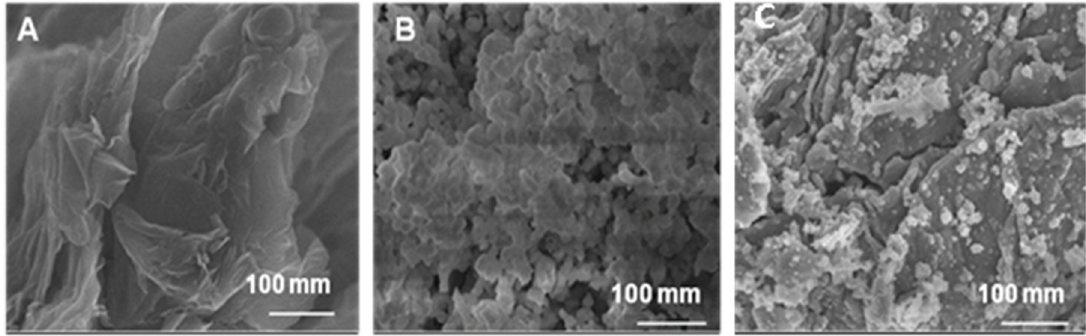
Figure 1. Images of ( A ) GO; ( B ) MnO 2 and ( C ) MnO 2 -GR nanocomposite.